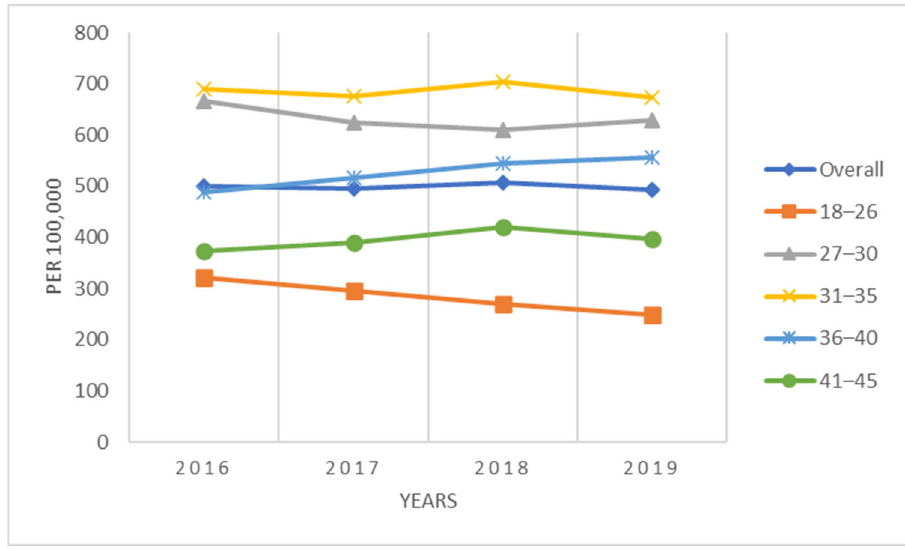
Figure 2. Annual incidence of conization per 100,000 screened women (2016–2019) .